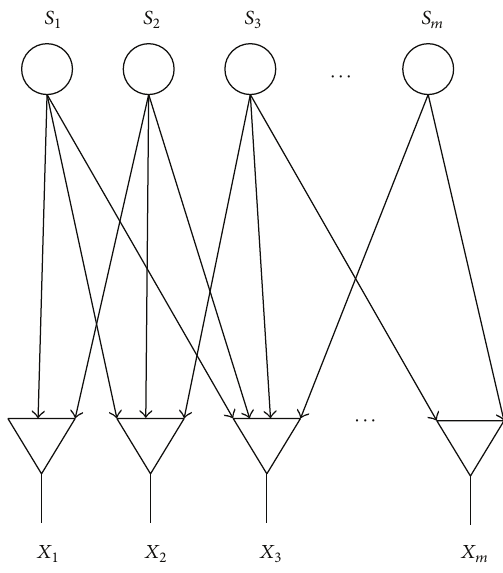
Figure 1: Signal mixing